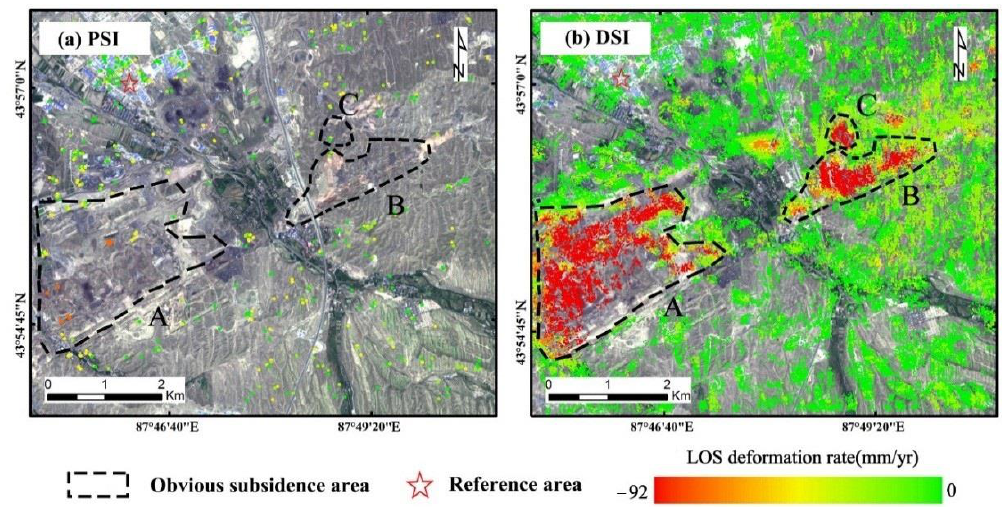
Figure 2. Ground subsidence results: ( a ) persistent scatter interferometry (PSI); ( b ) distributed scatterer interferometry (DSI) method.